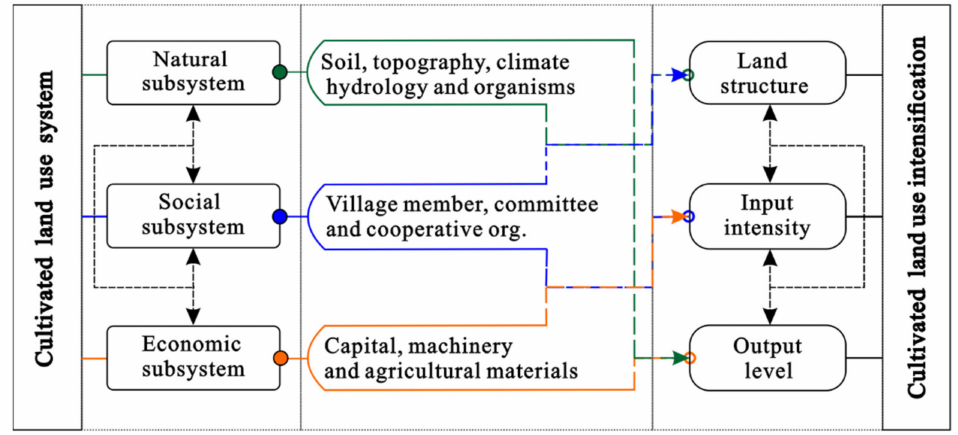
Figure 1. Logistics between the cultivated land use system and